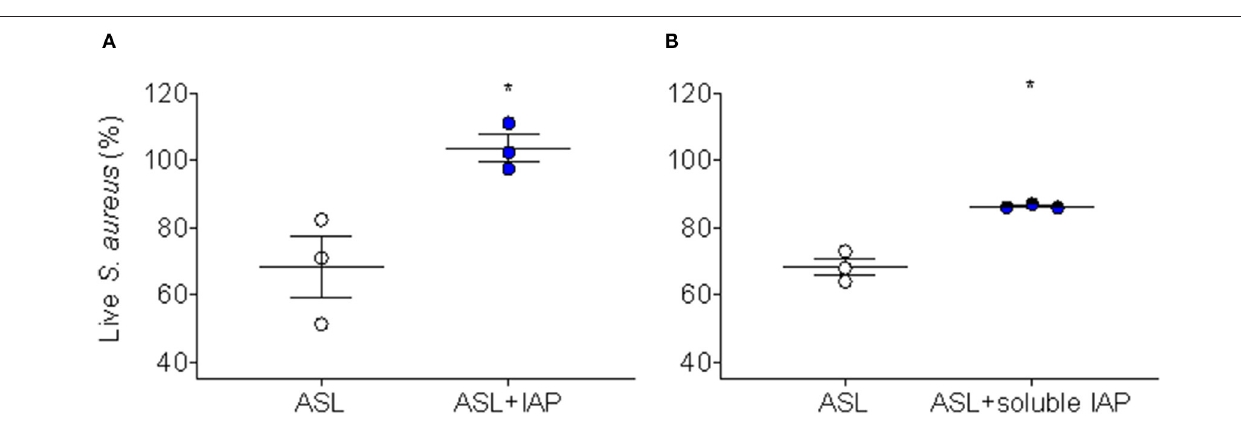
within 10 min to the bacteria RLUs at t = 0 per condition, Figure 2B